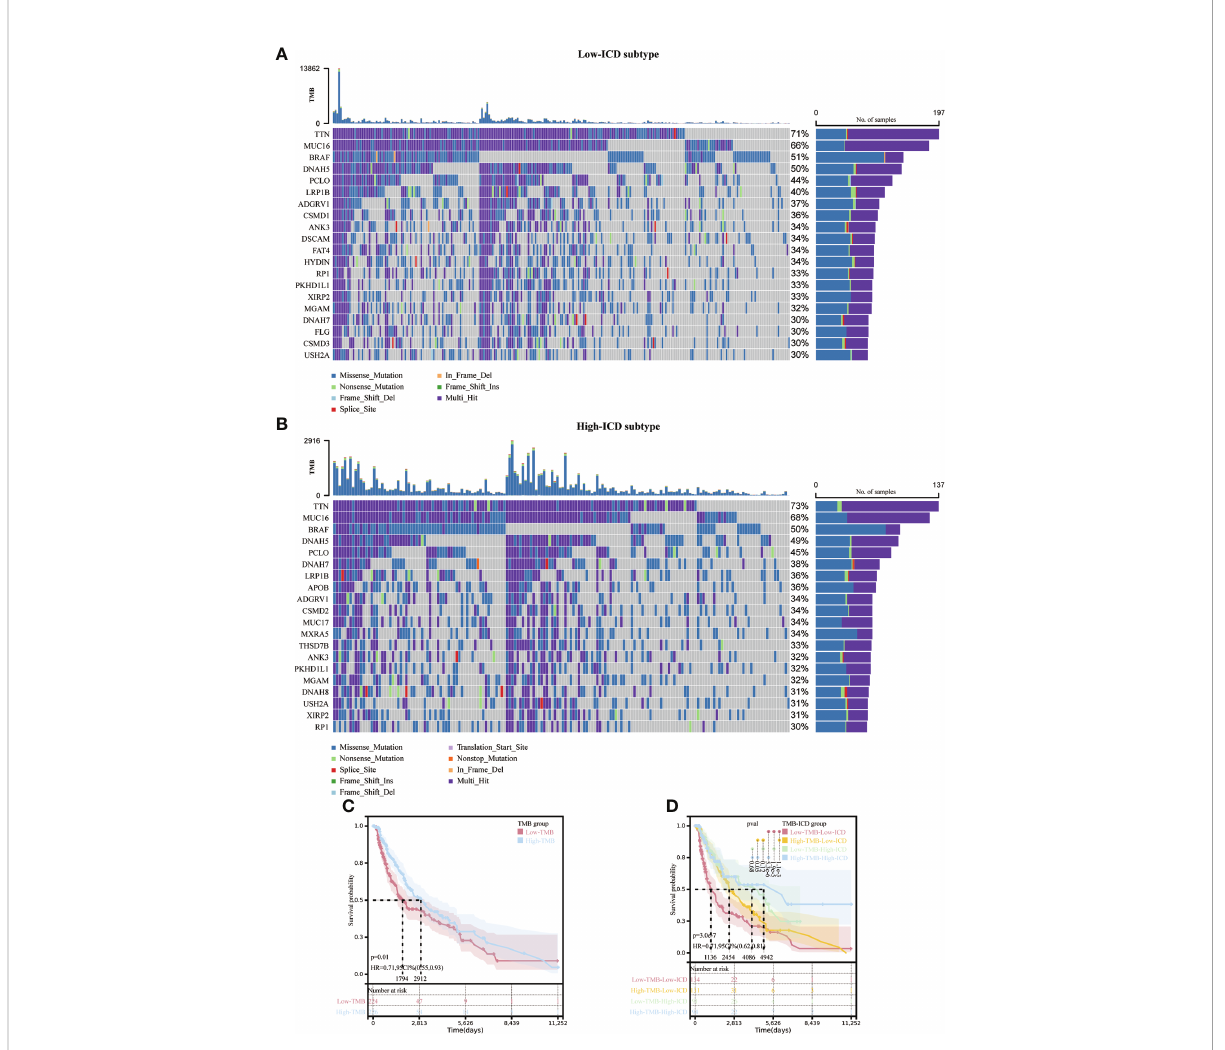
FIGURE 4 Correlation of different ICD subtypes with somatic mutations. Oncoprint visualizes the ten most frequently mutated genes in the ICD-low subtype (A) and the ICD-high subtype (B) . Kaplan-Meier curves for the high TMB and low TMB groups (C) .Kaplan-Meier curve strati fi cation of patients according to TMB and ICD genetic characteristics (D)